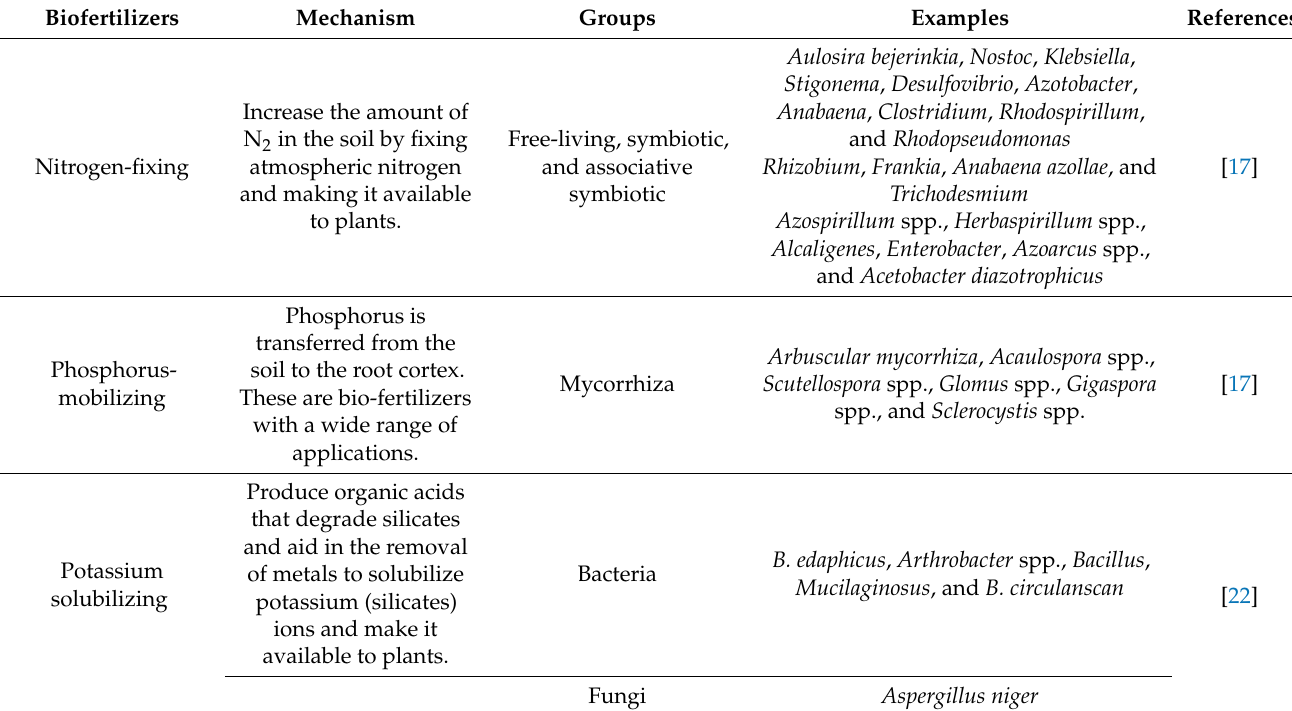
Table 1. Classification of biofertilizers and their mechanism of